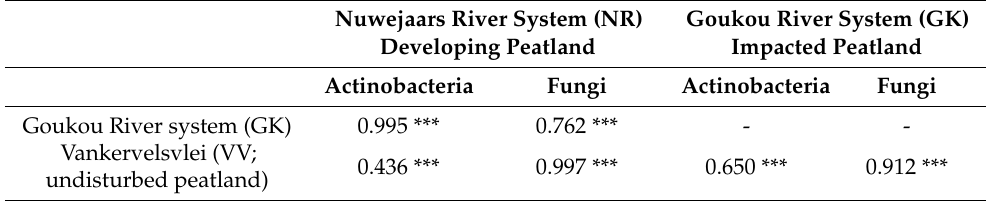
Table 3. Results of one-way unordered ANOSIM: R values all sites.